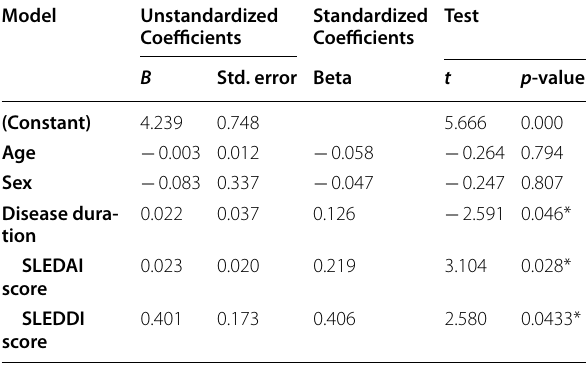
Table 3 Multiple logistic regression analysis of different risk factors affecting